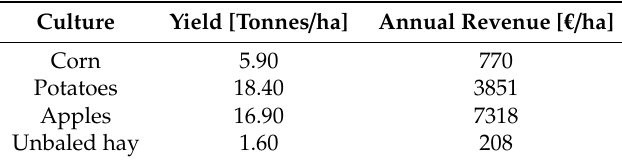
Table 3. Agricultural production and maximum potential losses due to flooding, expressed in terms of annual revenue.